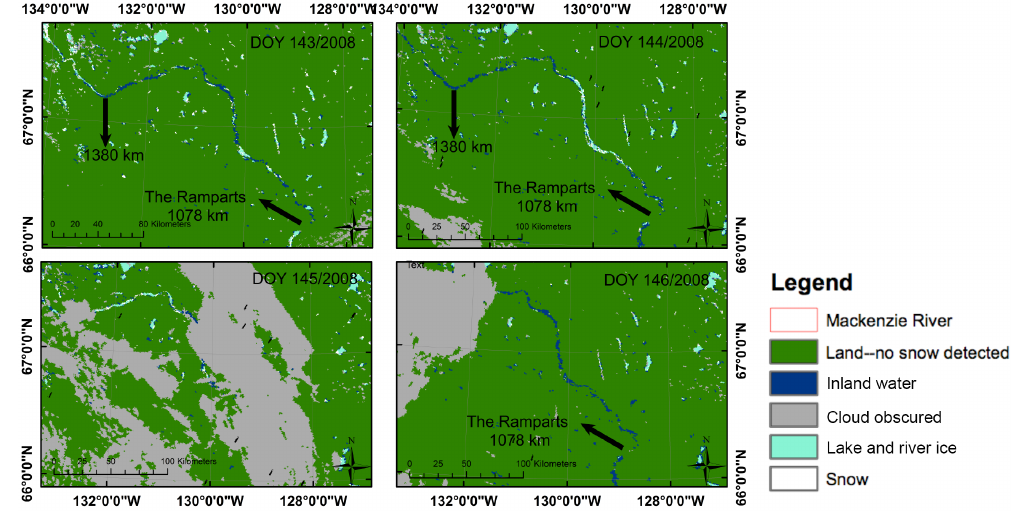
Figure 10. Ice flushing event recorded in 2008 between DOYs 143 and